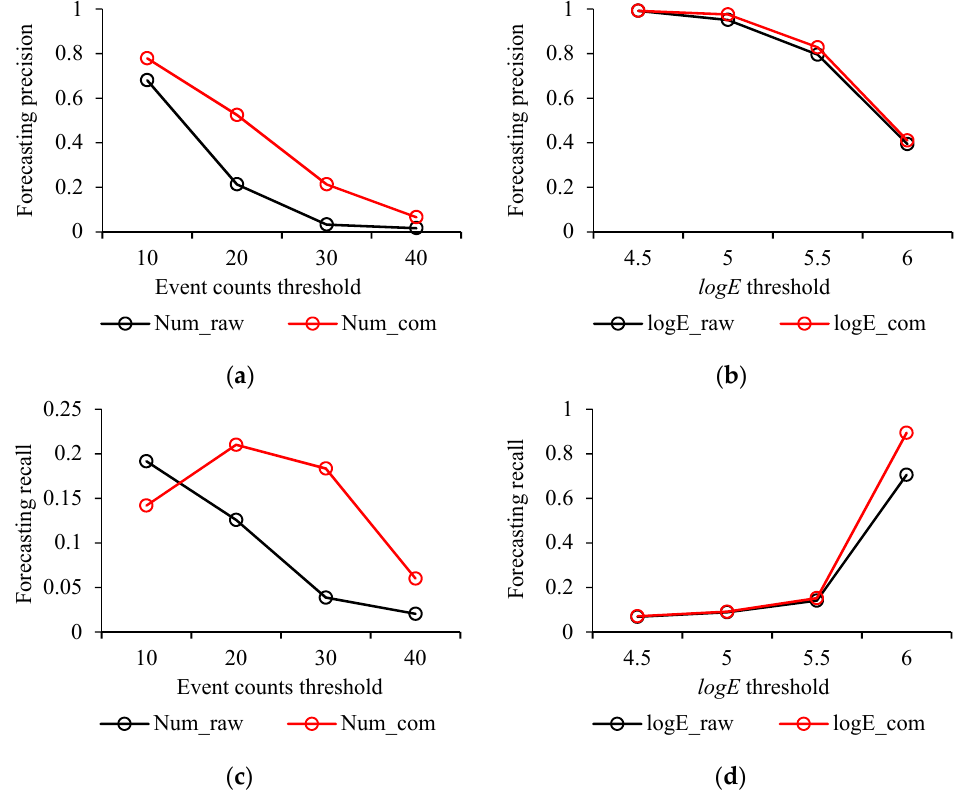
Figure 14. Precision ( a , b ) and recall ( c , d ) for forecasting 𝑙𝑜𝑔𝐸 > 5 events using the raw seismic data and compensated seismic data based on different event counts and energy thresholds.